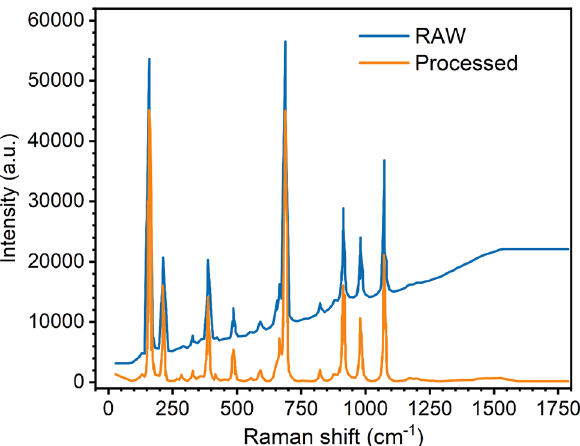
Figure 3. The effect of processing the raw data using Savitzky Golay filter and background subtraction using penalized least squares. The processed data does not suffer from the effects of the noise and